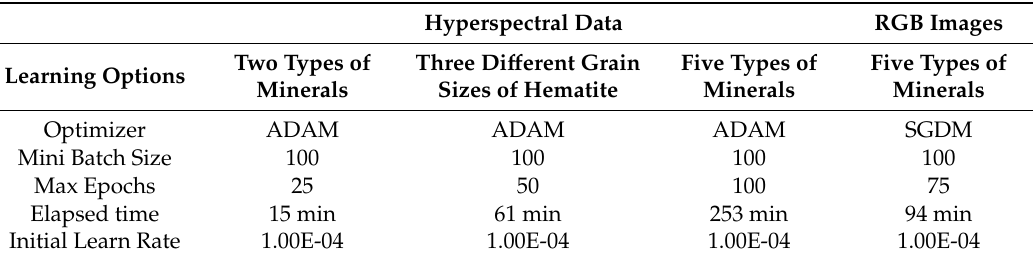
Table 5. Learning options of deep learning. ADAM (adaptive moment estimation).